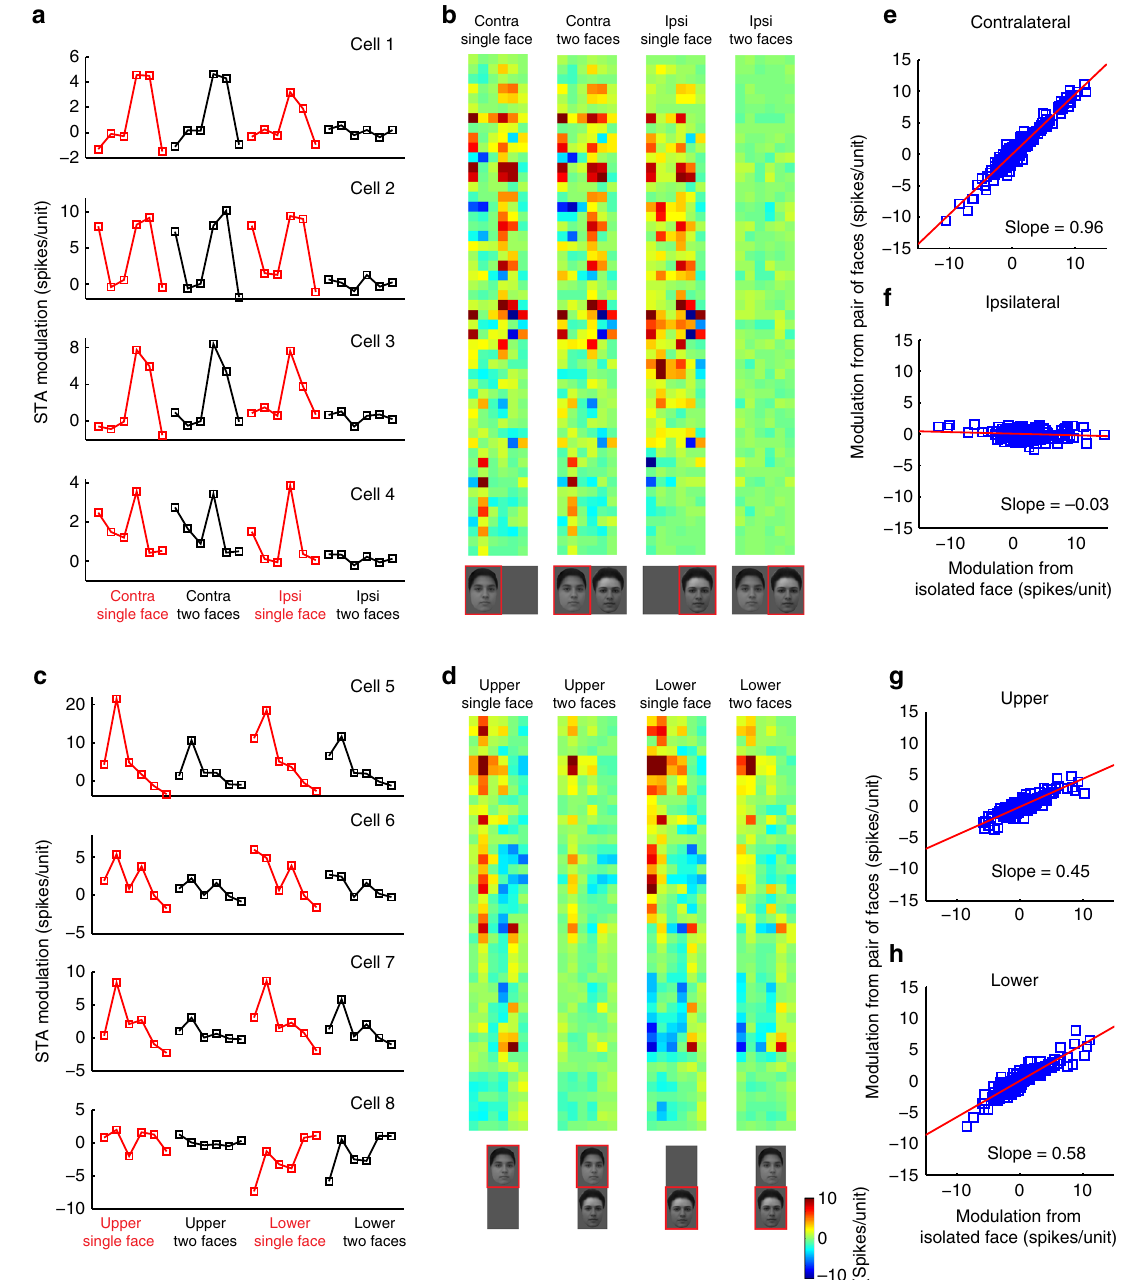
Fig. 4 ML responses to face-face pairs. a STAs for four example neurons, for faces presented in the horizontal con fi guration. For each neuron, the STA was computed for four different conditions: (1) a contralateral face presented in isolation, (2) a contralateral face presented as part of a pair, (3) an ipsilateral face presented in isolation, and (4) an ipsilateral face presented as part of a pair. b STAs for all recorded neurons when two faces presented in the horizontal con fi guration. Each row represents one neuron, and each column represents one face space dimension. c , d Same as a and b , for the condition in which two faces were presented in the vertical con fi guration. For each neuron, the STA was computed for four different conditions: (1) an upper face presented in isolation, (2) an upper face presented as part of a pair, (3) a lower face presented in isolation, and (4) a lower face presented as part of a pair. e STA values from the contralateral face obtained in the single face condition (horizontal) plotted against STA values from the contralateral face obtained in the paired face condition (vertical). The red line indicates the best linear fi t of the data. f Same as e , for STA values from ipsilateral faces. g Same as e , for STA values from faces presented above the fi xation point. h Same as e , for STA values from faces presented below the fi xation point. The faces in b , d were created by the computer program described in the Chang and Tsao isolated and paired conditions. Figure 4e shows a scatter plot of gain for the two conditions. This suggests that cells are using an STA values measured for contralateral faces presented in a pair exact contralateral-take-all rule in this situation, and not some vs. contralateral faces presented in isolation; each cell contributes other rank-preserving interaction for generating clutter invar- six points to the plot, corresponding to the six dimensions of the iance 9 . Figure 4f shows a scatter plot of STA values measured for ipsilateral faces presented in a pair vs. ipsilateral faces presented STA. The slope of the plot is 0.96, indicating almost identical STA